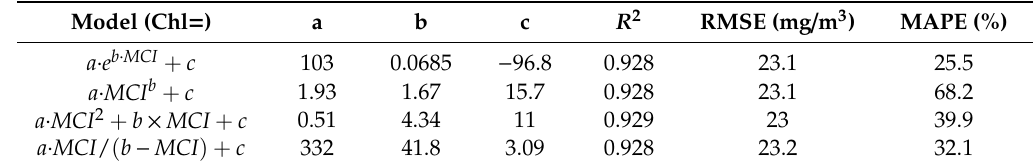
Table 2. Comparison of di ff erent theoretical models for the relationship between [Chl-a] and MCI. Note that MCI was multiplied by 10 3 for the coe ffi cients below.